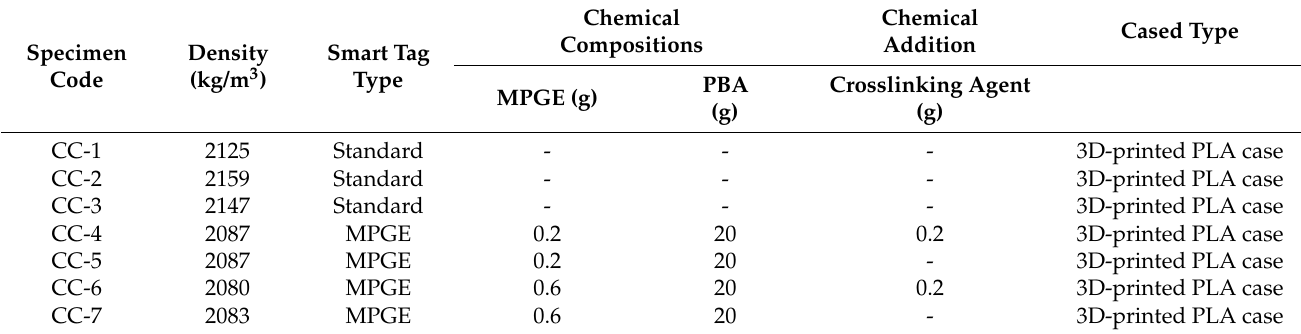
Figure 5. A 3 mm-deep 3D-printed case.